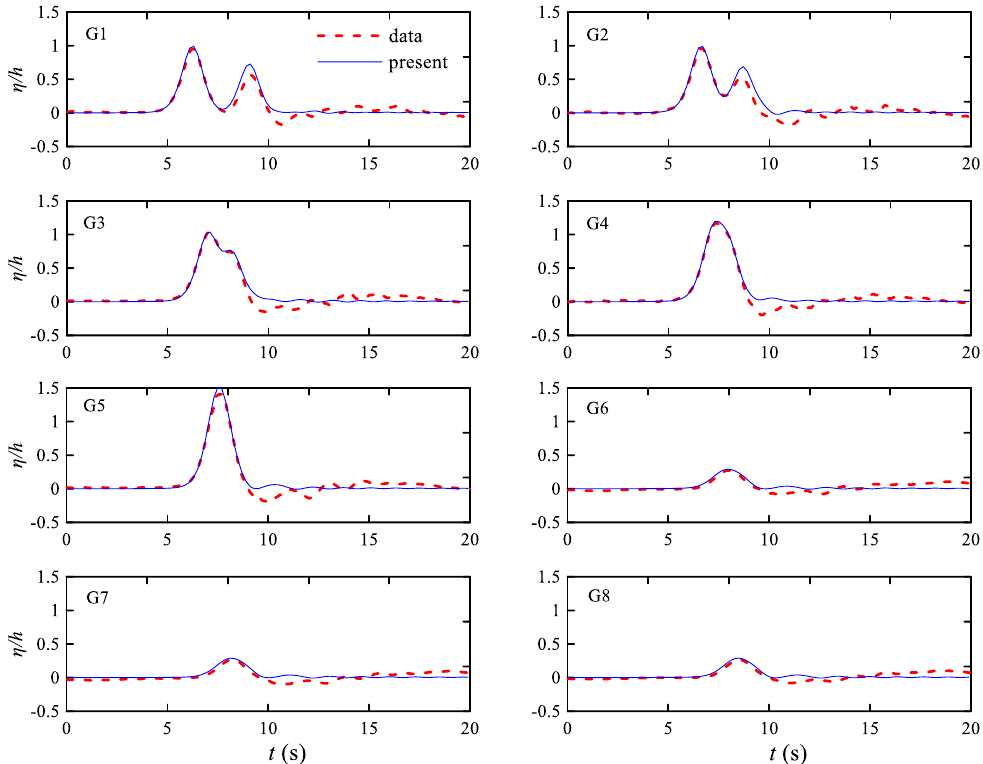
Figure 4. Comparison of free surface elevation between present simulation (solid line) and experi- mental data (dashed line) for Case S1 ( H / h = 0.12).